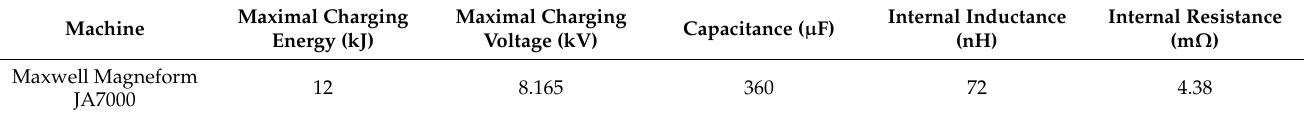
Table 5. Characteristics of the pulse